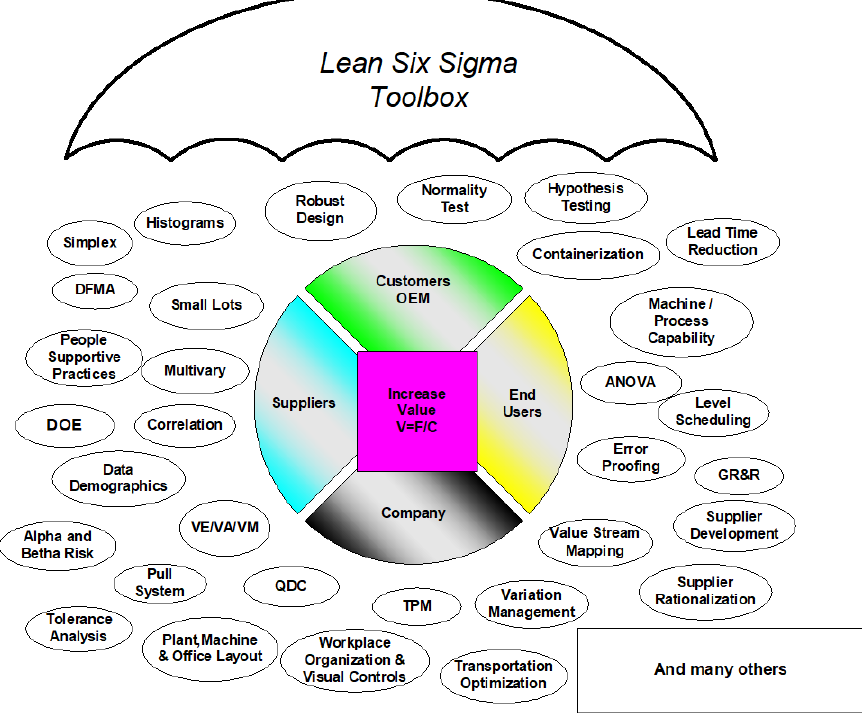
Fig. 1. Lean Six Sigma toolbox-Synergy (Mladjenovic,